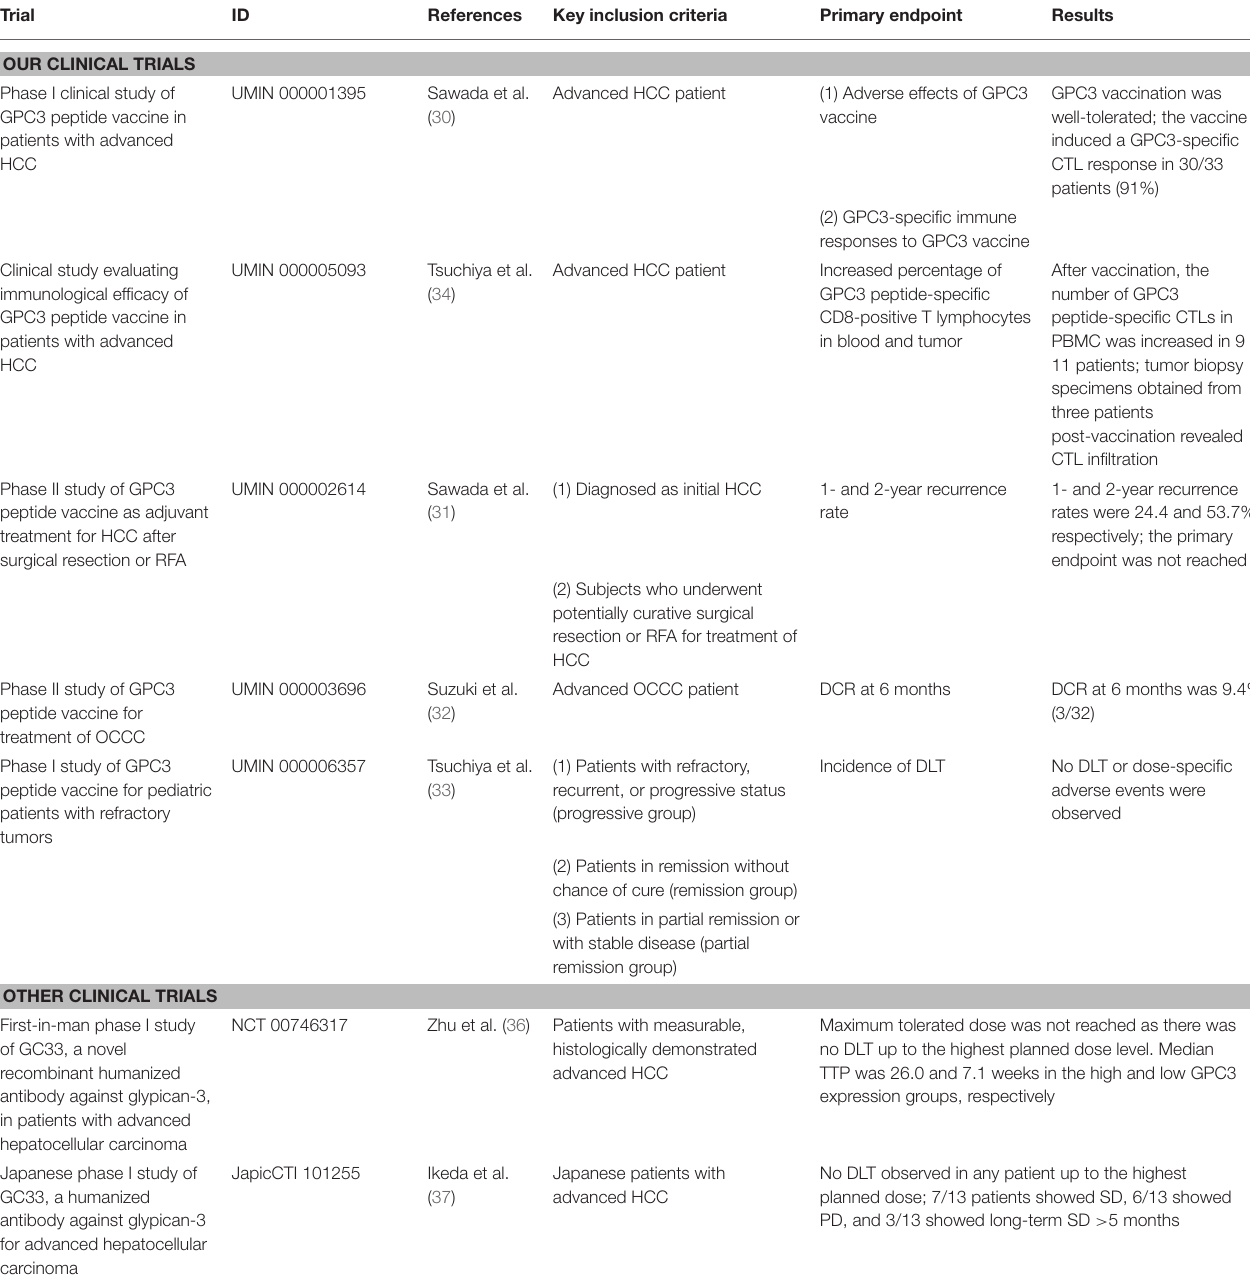
TABLE 1 | Summary of clinical trials for cancer immunotherapy targeting